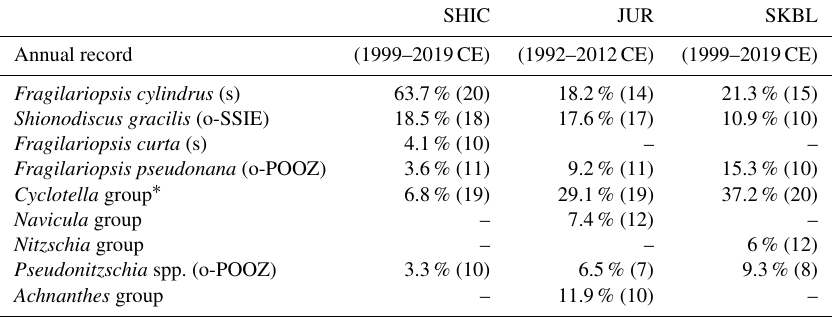
Table A1. Relative abundance (%) and frequency (no. of samples) of main diatom taxa in annual diatom records for each ice core. ( ∗ ) Spec- imens of Cyclotella sensu lato (including Lindavia , Discostella , Tertiarius and Pantocsekiella ). (s): sea-ice-affiliated diatom. (o-SSIE): open ocean – diatom affiliated with the seasonal sea ice edge. (o-POOZ): open ocean – diatom species or group affiliated with the permanently open ocean zone. Table modified from Tetzner et al. (2022a).